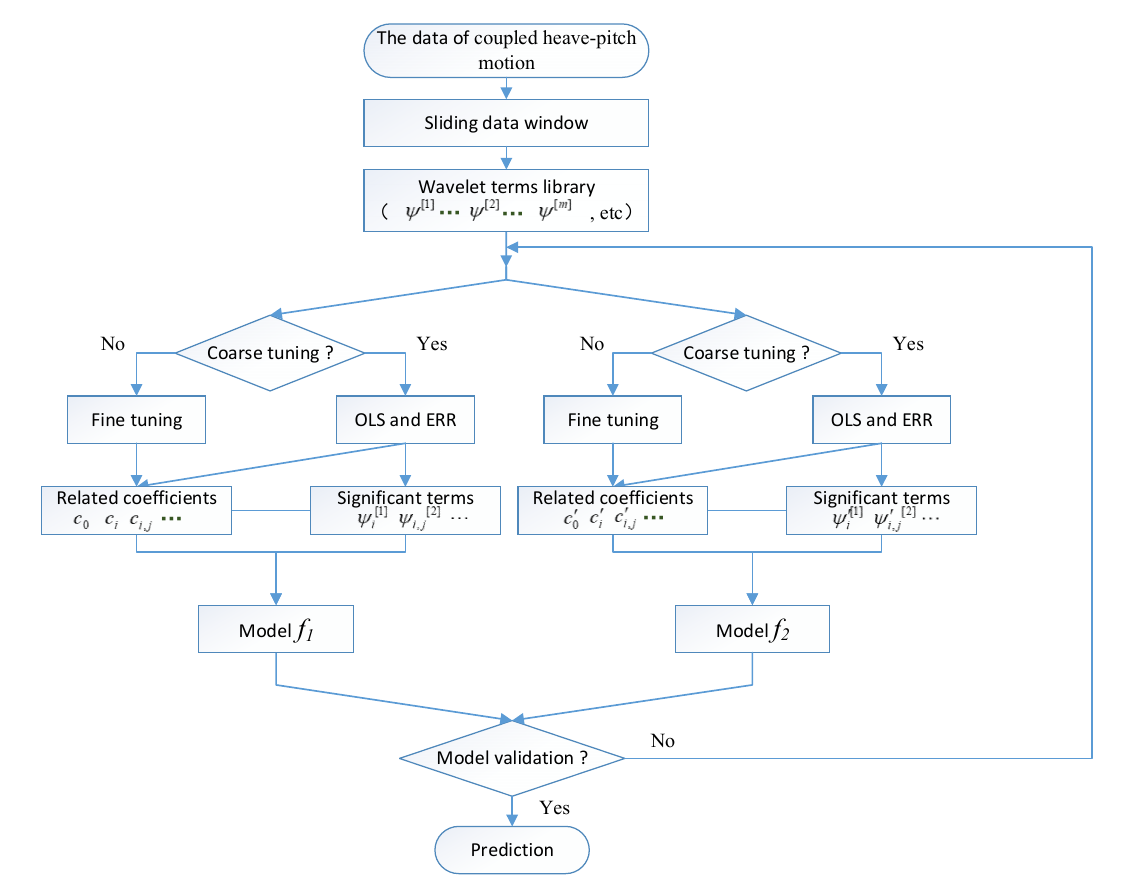
Figure 1. Flow chart of the coarse-tuning and fine-tuning algorithm for the coupled heave-pitch motions. The OLS algorithm and ERR criterion are applied to realize the coarse-tuning